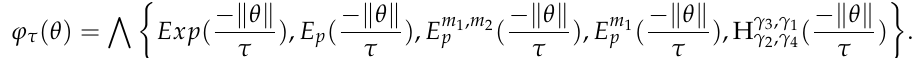
Table 1. Calculation of aggregation function according to special functions for different values.